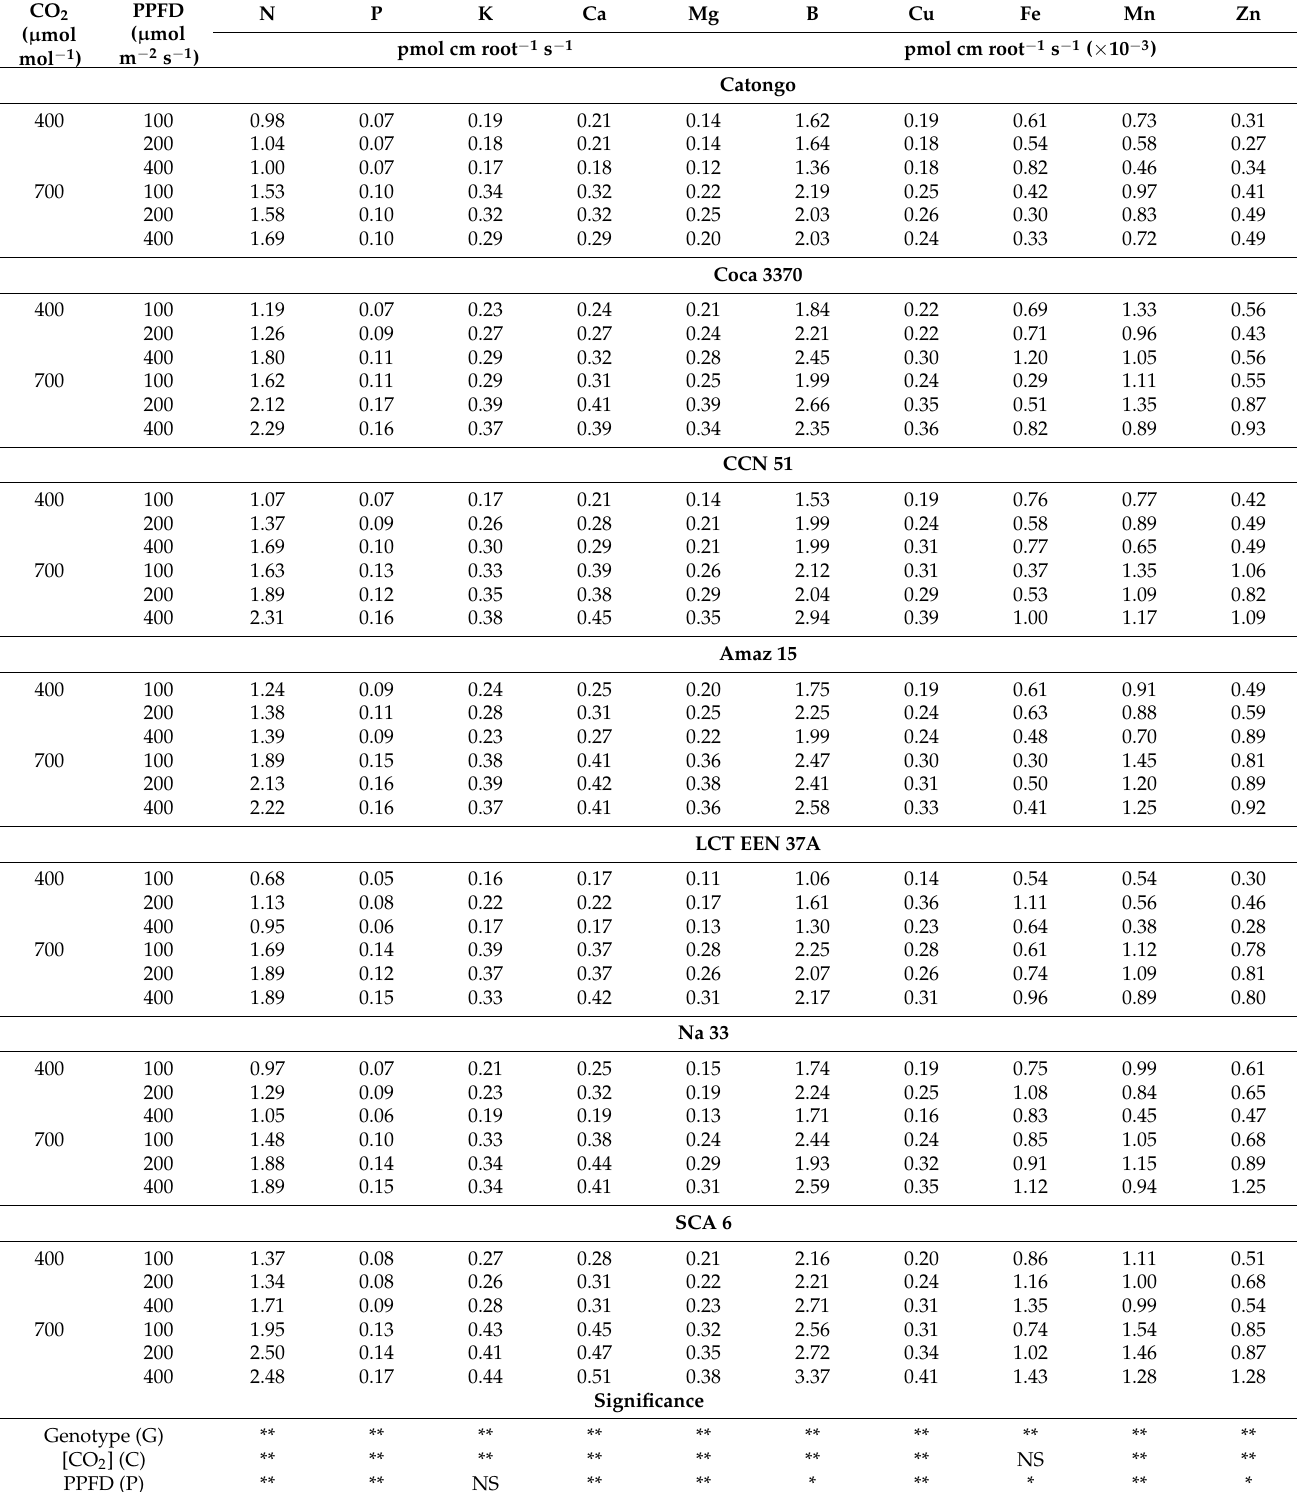
Table 5. The effect of [CO 2 ] and photosynthetic photon flux density (PPFD) on macro–micro influx by root length of seven cacao